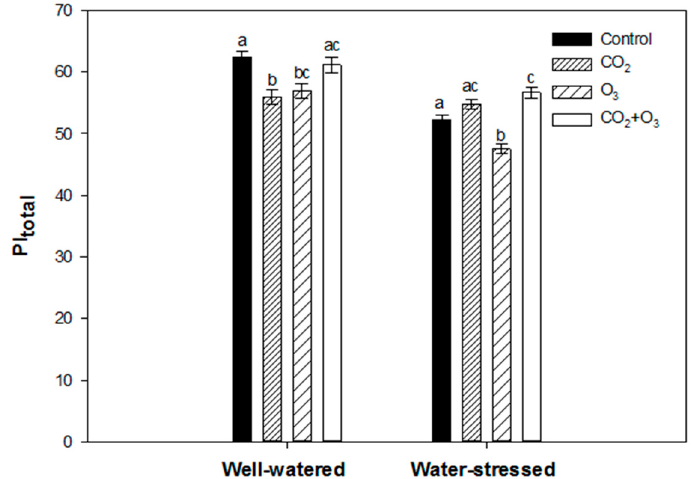
Figure 8. Average (of all weeks) PI total of wheat plants exposed to CO 2 , O 3 and CO 2 + O 3 under well-watered and water-stressed conditions for four weeks. For the same water treatment, the di ff erent letters show statistically significant di ff erences ( p < 0.05 ).